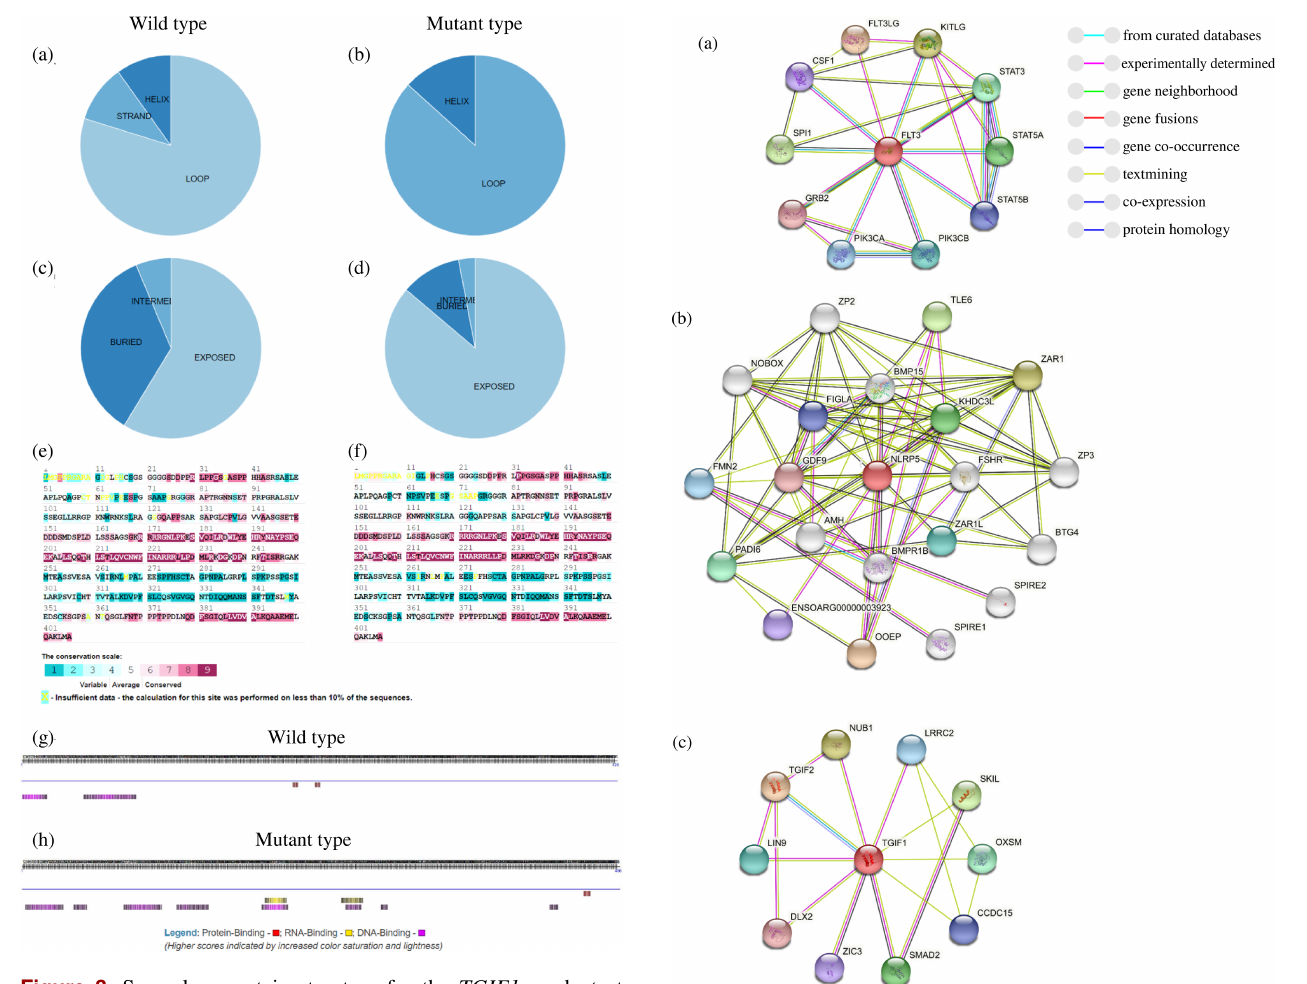
Figure 3. Secondary protein structure for the TGIF1 product at g.37866222C > T based on its predicted amino acid sequence: (a, b) secondary structure composition of wild and mutant type, respec- tively; (c, d) solvent accessibility of wild and mutant type, respec- tively; (e, f) ConSurf results of wild and mutant type, respectively; and (g, h) binding site prediction of wild and mutant type, respec- tively.